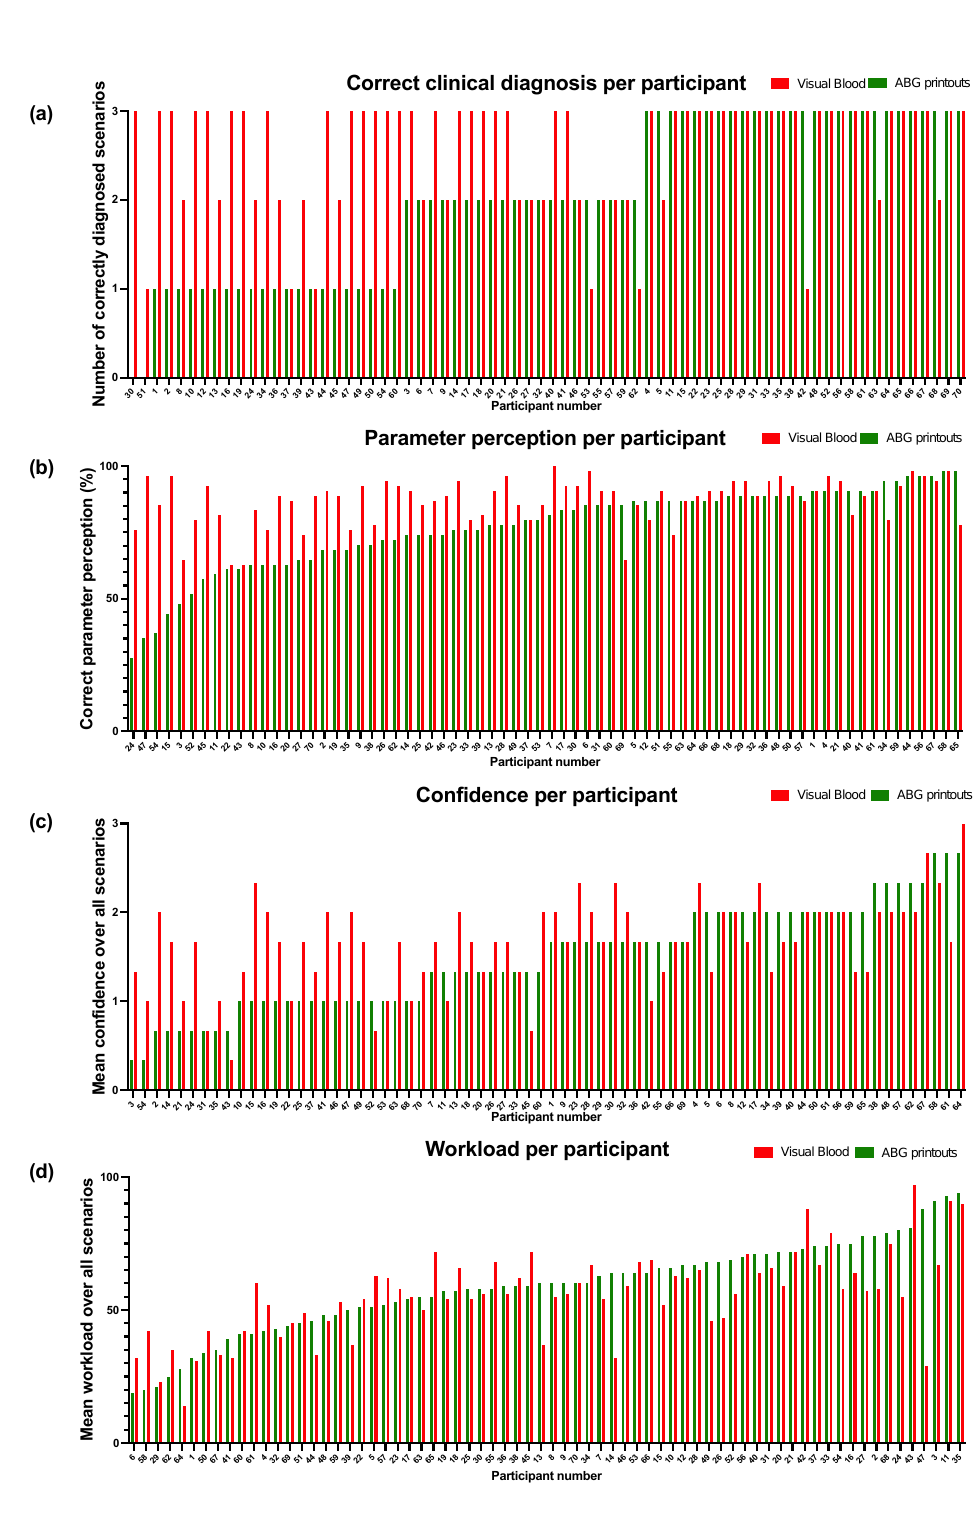
Figure 2. The study results on an individual participant level for correct clinical diagnosis, parameter perception, perceived confidence, and workload. The 70 participants are ranked on the x -axis from left to right in ascending order according to their achieved diagnostic and parameter perception performance, perceived confidence, or workload, respectively, with conventional ABG printout.